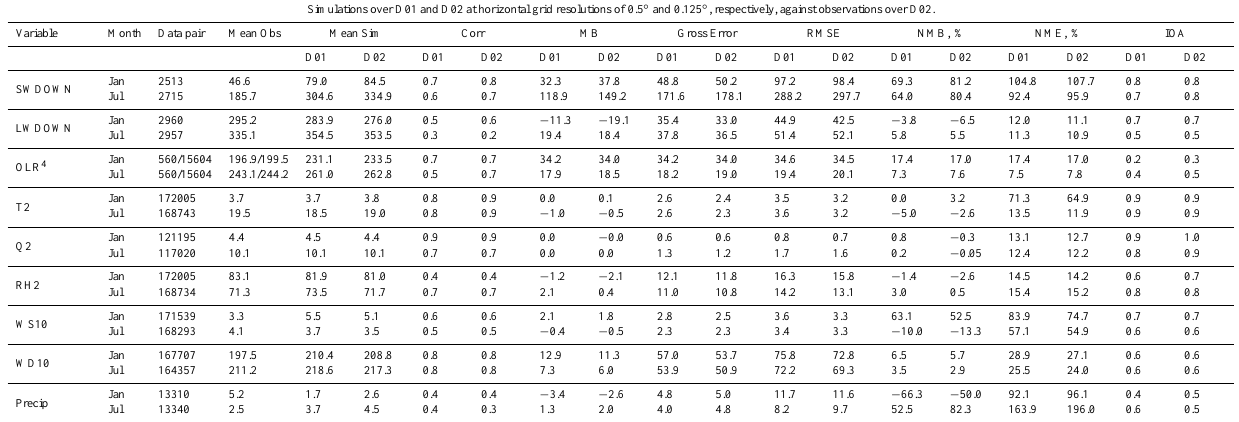
Table 4b. Comparison of performance statistics of WRF in January and July 2001 1 , 2